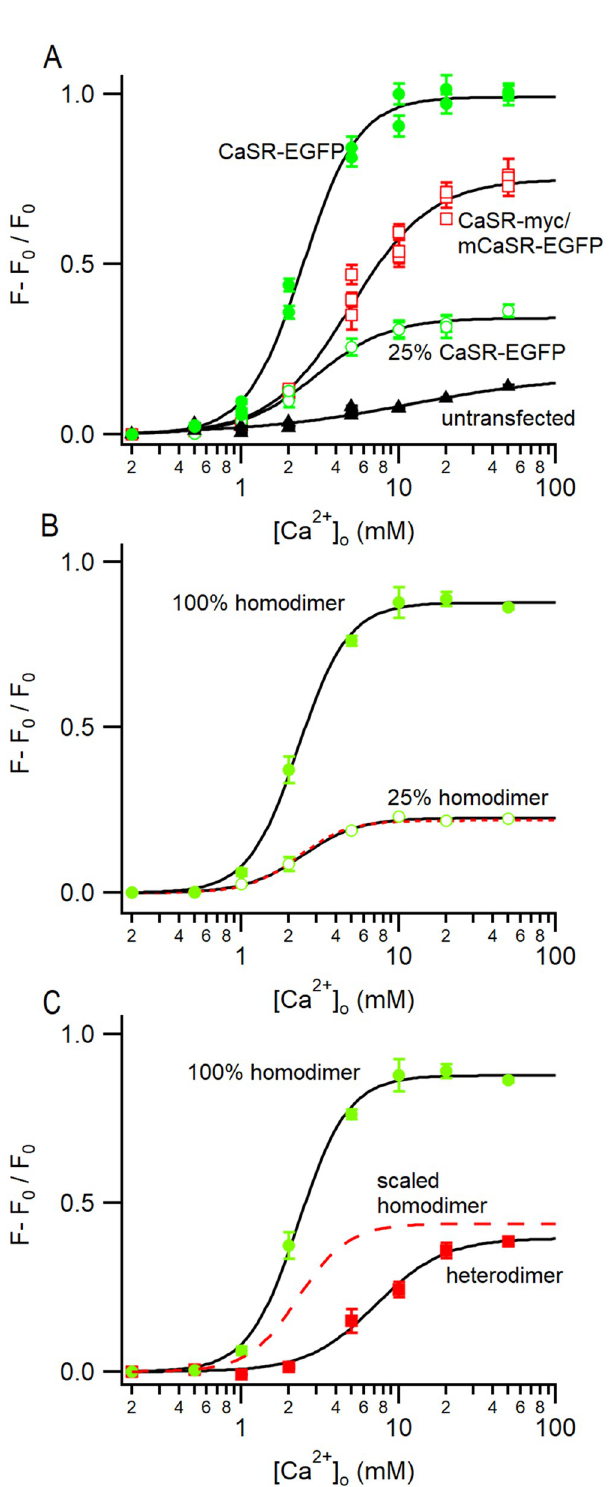
Fig 6. WT/mutant CaSR heterodimers have a lower affinity but similar efficacy as WT CaSR. A, concentration- response relationship of [Ca 2+ ] o dependent mobilization of [Ca 2+ ] i in HEK 293 cells non-transfected or transfected with 0.25 nM pEGFP/CaSR, 0.125 nM pEGFP/mCaSR and 0.125 nM pcDNA-myc/CaSR, or 0.06 nM pEGFP/CaSR. [Ca 2+ ] i changes, ((F-F 0 ) / F 0 ) was measured in cells loaded with 2 μ M X-rhod1 following the increase in [Ca 2+ ] o from 0.2 mM. Differences between basal and peak [Ca 2+ ] i were plotted against [Ca 2+ ] o . Values are means ± SEM and fitted